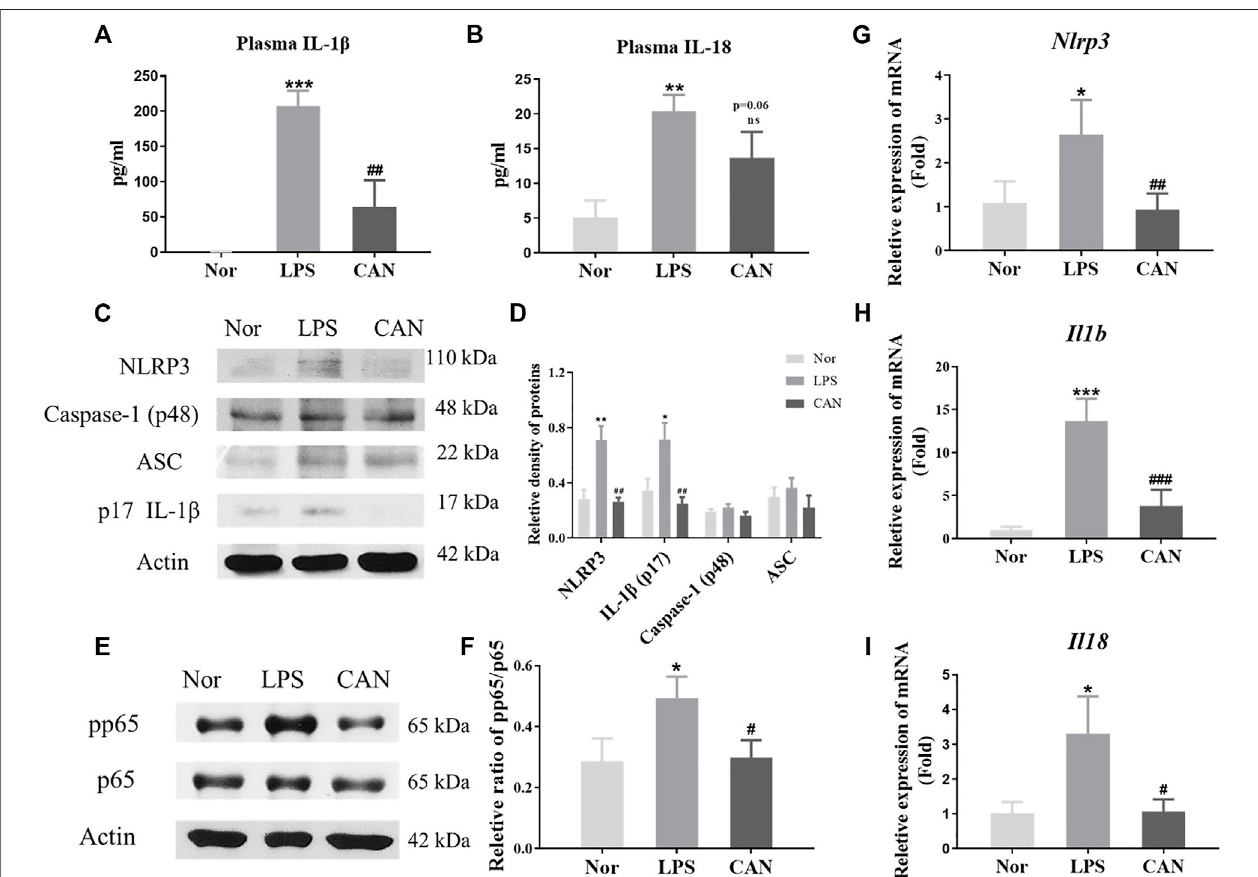
FIGURE 1 | Canagli fl ozin inhibits NLRP3-in fl ammasome activation in LPS-treated NIH mice. CAN was administered intragastrically for 3 consecutive days. The normalandLPSgroupsweregiventhesameamountofvehicle.Aftertreatment,themicewereintraperitoneallyinjectedwithLPS(10 mg/kg).After4 hofLPSinduction, blood samples and lung tissues were collected for further assays. The plasma levels of (A) IL-1 β and (B) IL-18 were measured by ELISA. Protein levels of (C,D) NLRP3, Caspase-1,ASC,IL-1 β and (E,F) phosphorylation ofp65inlung tissues weremeasured using westernblotting.ThemRNAlevel of (G) NLRP3, (H) IL-1 β and (I) IL- 18 in lung tissues were quanti fi ed by qPCR. Nor, normal control group; LPS, untreated LPS control group; CAN, CAN-treated LPS group. Data were expressed as mean ± SD ( n = 3). Differences with a probability value of < 0.05 were considered signi fi cant (* p < 0.05, ** p < 0.01, *** p < 0.001 vs. Nor; # p < 0.05, ## p < 0.01, ### p < 0.001 vs.